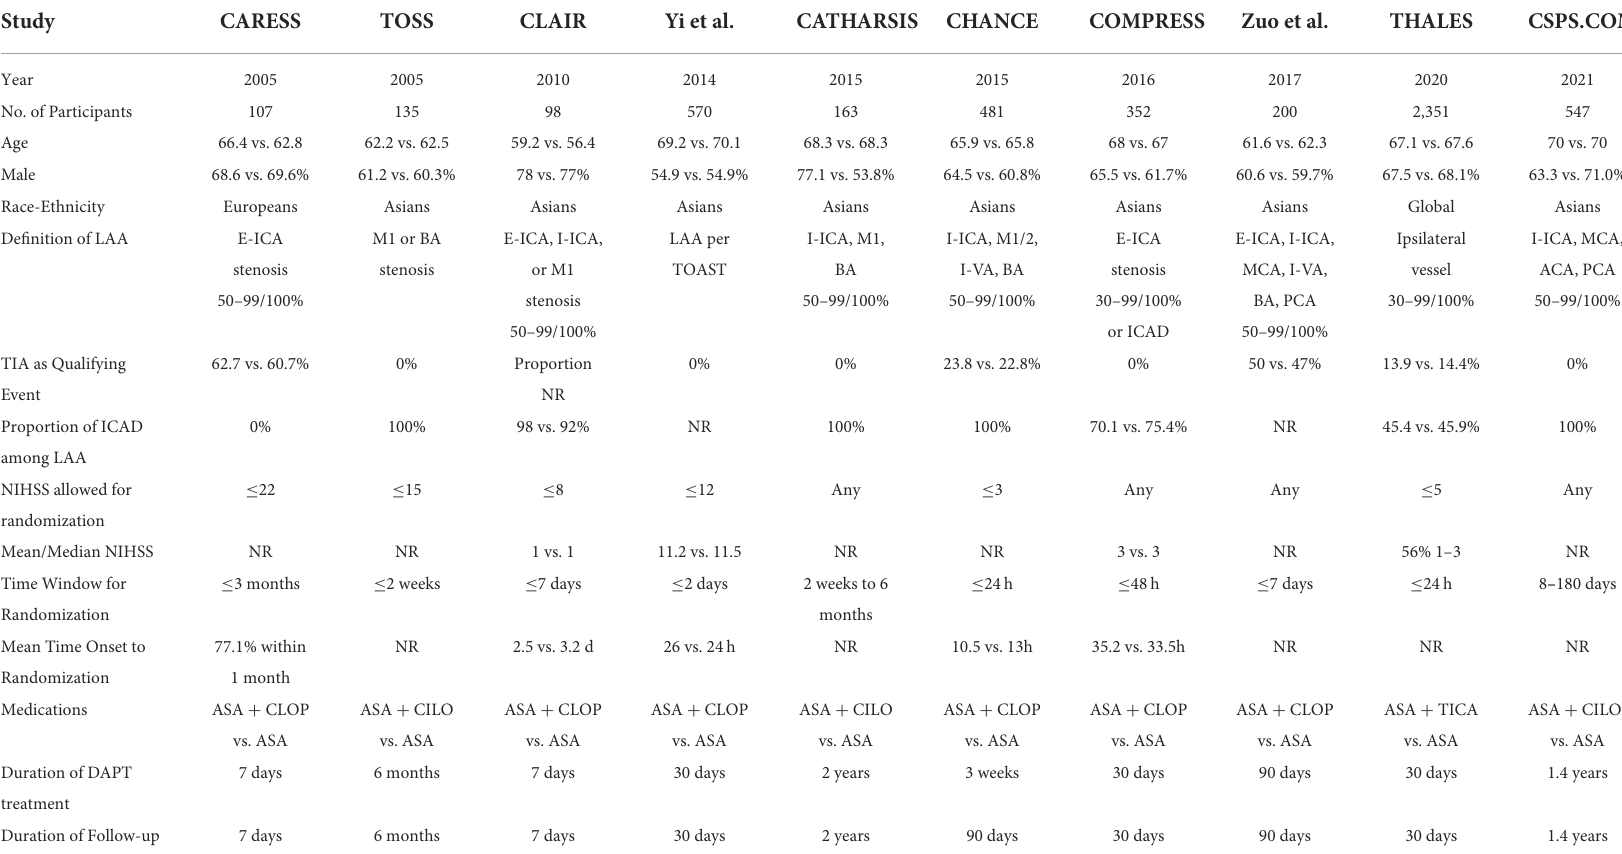
TABLE 1 Design and population characteristics of included